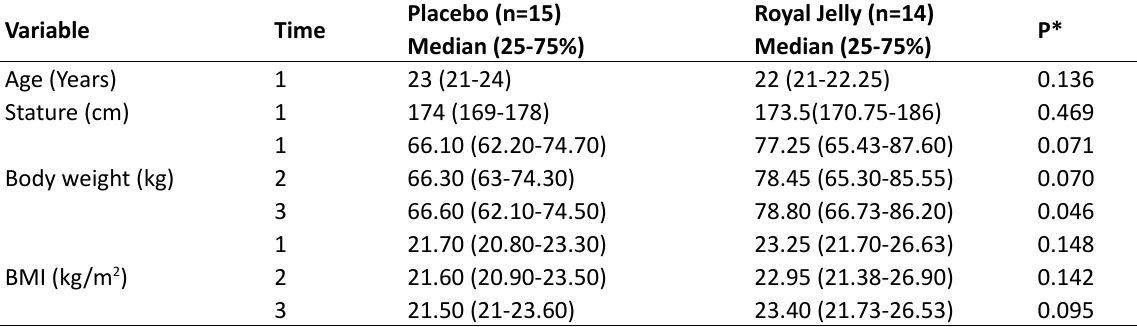
Table 1. Characteristics of the control and experimental group